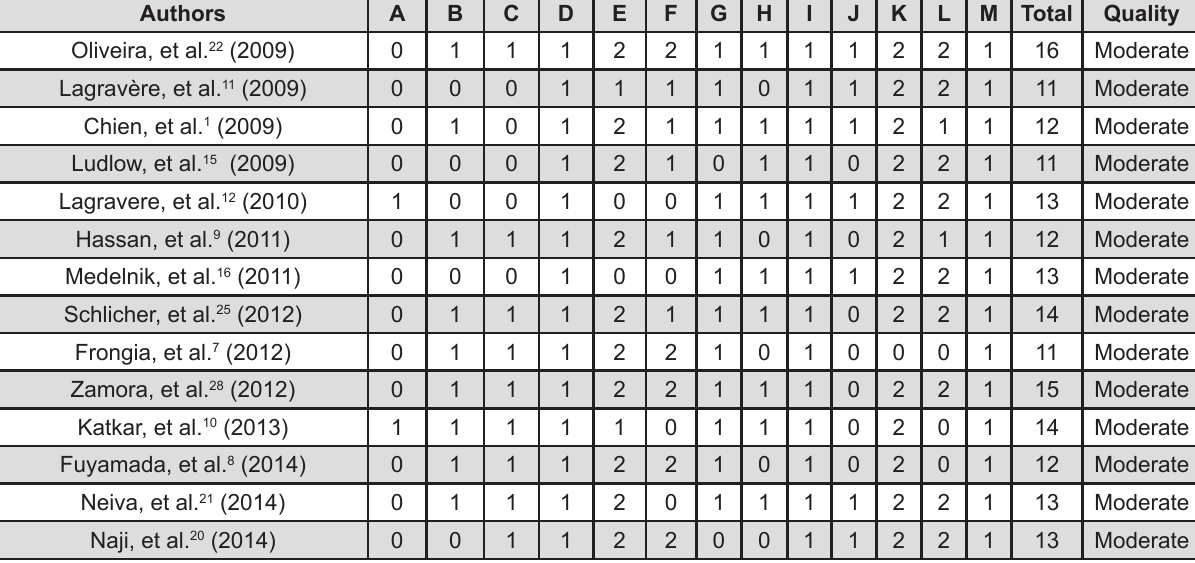
Figure 4- Methodological quality scores of the selected articles